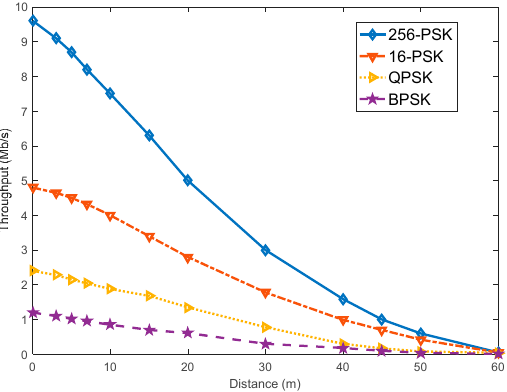
Figure 8. Comparative throughput of BPSK, QPSK, 16-PSK, 256-PSK.